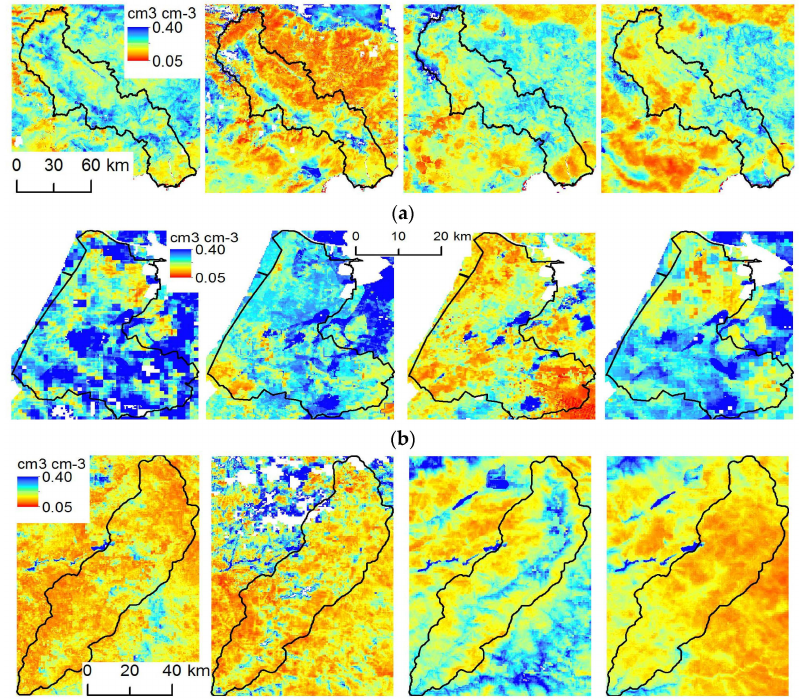
Figure 2. Spatial variability of SM in the study areas: ( a ) Nestos 24 November 2012, 1 January 2013, 9 May 2013, 18 June 2013; ( b ) Rijnland 7 October 2012, 25 January 2013, 18 February 2013, 5 August 2013; ( c ) Tamega 7 October 2012, 24 November 2012, 1 January 2013, 4 August 2013. No-data pixels appear in